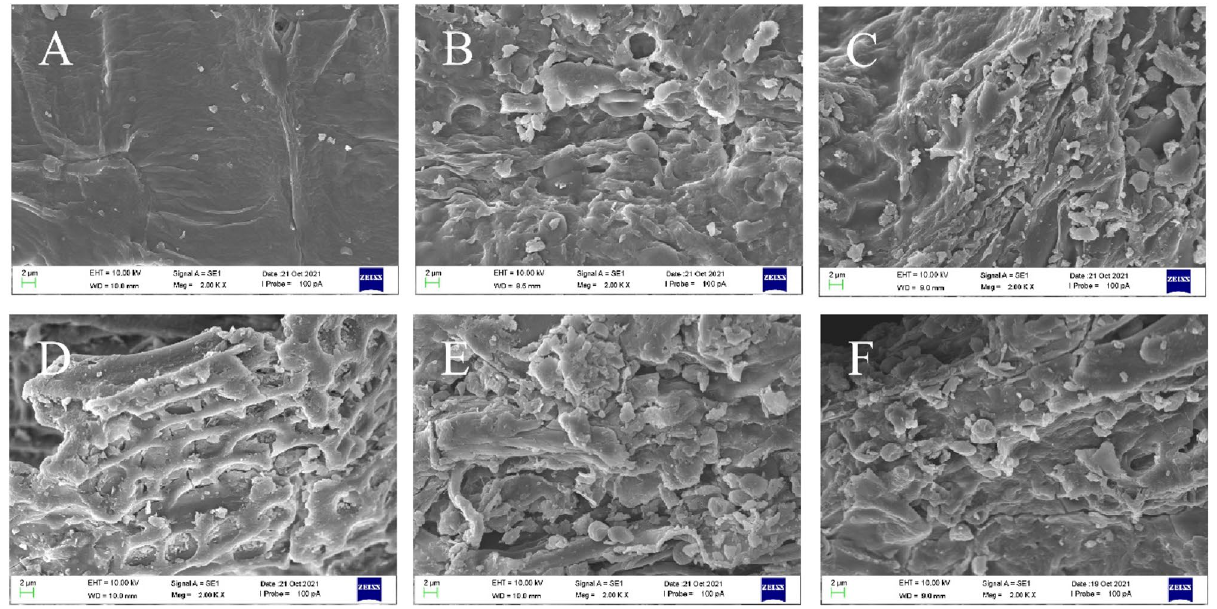
Figure 2. Scanning electron micrographs of each sample of Radix Astragali (( A ) the control, ( B ) the control in the gastric digestion, ( C ) the control in the enteric II digestion, ( D ) the FRA, ( E ) the FRA in the gastric digestion, ( F ) the FRA in the enteric II digestion).